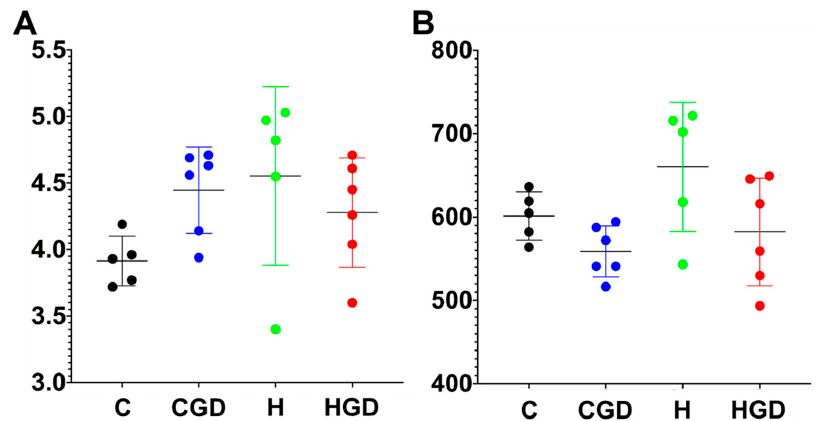
Figure 7. Shannon diversity ( A ) and richness ( B ) of faecal samples. C, corn starch diet-fed rats; CGD, corn starch diet-fed rats treated with Garcinia dulcis rind powder; H, high-carbohydrate, high-fat diet-fed rats; HGD, high-carbohydrate, high-fat diet-fed rats treated with Garcinia dulcis rind powder.